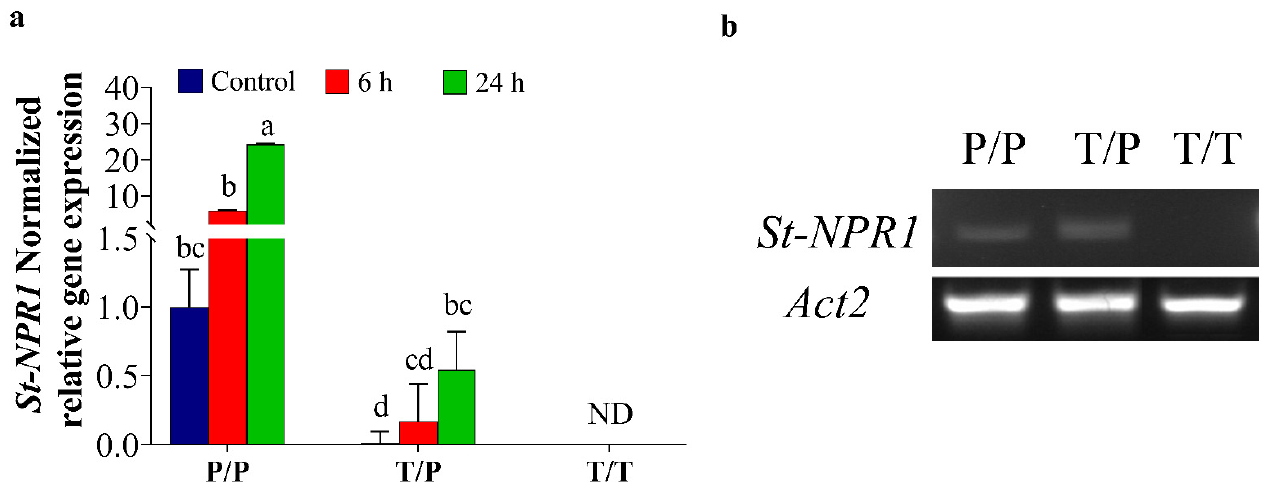
Figure 2. Quantitative and semi-quantitative expression of StNPR1 in tomato scion. The plants were stressed by watering with 30% PEG. A tissue sampled 5 cm above the graft union at 6 h and 24 h after PEG treatment was used for RNA extractions and gene expression studies. ( a ) The normalized relative gene expression of StNPR1 . The bars represent the means ± SEM of three biological replicates. The relative expression of potato genes was calculated relative to the homografted potato control (P/P) and normalized to TIP . Different letters in the graph indicate significant differences ( p ≤ 0.05) in relative gene expression between treatments after Tukey’s test, ND means no detected transcripts. ( b ) Semi-quantitative PCR results show the movement of StNPR1 transcripts from the potato rootstock into the tomato scion using potato-specific primers. Homografted potato (P/P), heterografted tomato scion/potato rootstock (T/P), and homografted tomato (T/T). Actin2 was used as a reference gene.